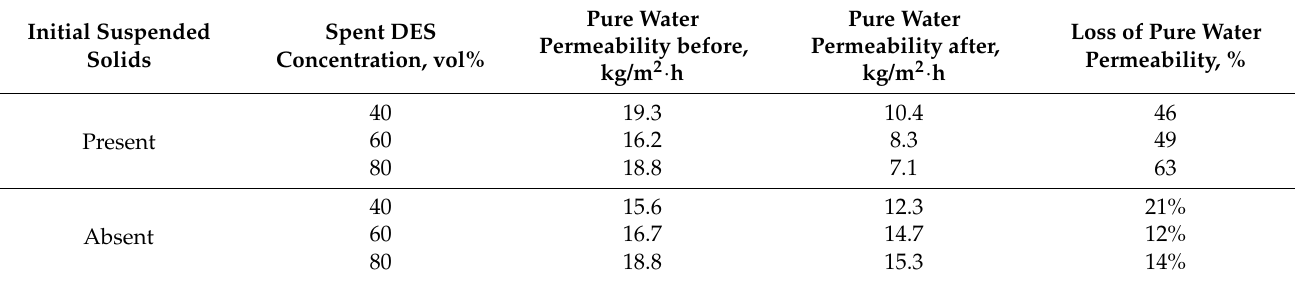
Table 2. Permeability of RC70PP before and after filtration. Filtration parameters: 3.5 bar, 45 ◦ C, 250 rpm. The solutions without suspended solids (“Absent”) had a prior Buchner filtration step before UF filtration.